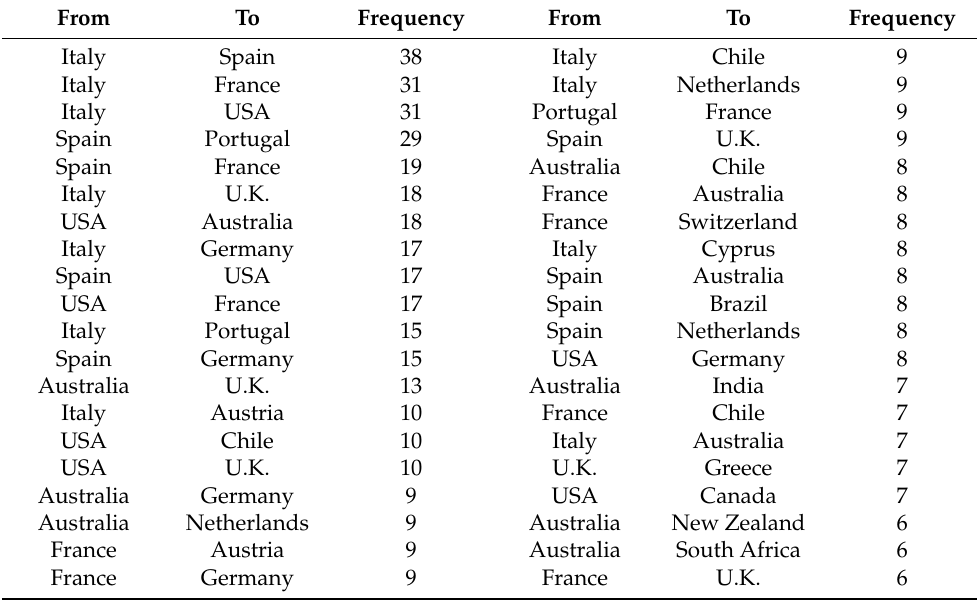
Table 12. International collaboration in research articles.